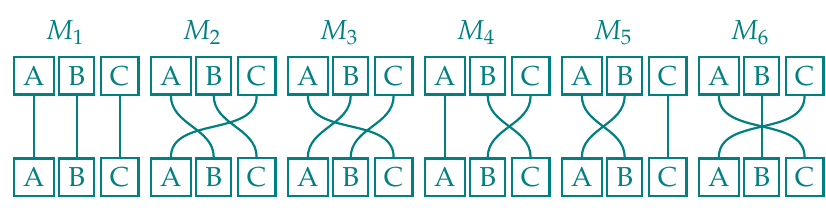
Figure 1. Set of possible configurations in a three-phase